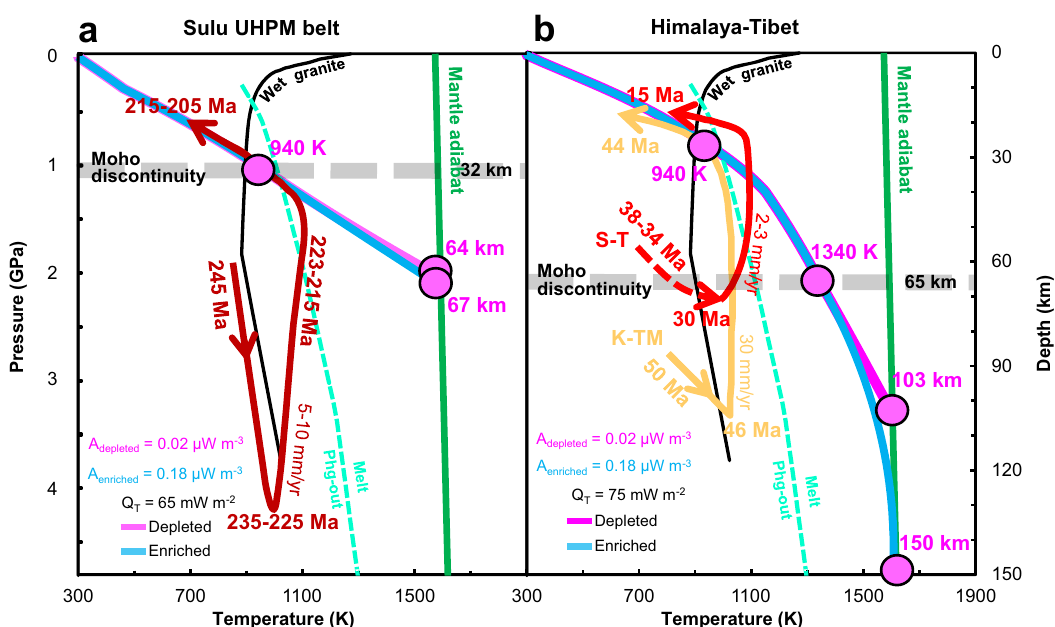
Fig.3|Geothermsofthecrustandlithosphericmantlebeneathorogenicbelts. a SuluUHPMbelt, b Himalaya-Tibet.Thethickpurpleandlightbluecurvesindicate the geotherm pro fi les calculated based on heat generation of 0.02 μ Wm − 3 in the depleted mantle and 0.18 μ Wm − 3 in the enriched mantle 51 , respectively. Solid black line:solidusofwetgranite 54 ;thicklightcyandashedline:dehydrationmeltingcurve of phengite 53 ; thick green line: mantle adiabatic line ( T m =1573+0.3 z where z is